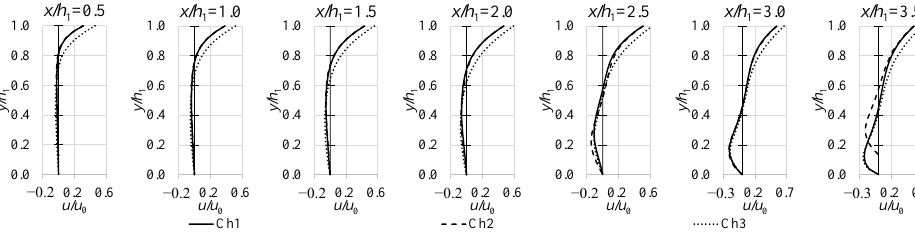
Figure 10. Pressure drop in Ch1, Ch2 and Ch3. 3.2. Investigation of Flow Topology in the x – z Plane Flow streamlines and velocity u profiles measured in the x – y plane are given at y / h 1 = 0.5 (in Figures 11 and 12). At Re = 100, lateral vortices are observed in all investigated cases. Note that longitudinal dimensions differ in every investigated channel due to ge- ometry limitations. For example, the growth of lateral vortices in Ch3 is determined by increased velocity in the centre of the channel; therefore, more kinetic energy is trans- ferred to lateral vortices, thus increasing their size. Further, since the recirculation zone in Ch3 is smaller than in other cases, the difference in reverse flow distribution between Ch3 and Ch1/Ch2 is evident, as can be observed from the x – z plane velocity u profiles (Figure 12). In Ch3, the separated shear layer reattaches to the cavity bottom (Figure 6), and the recirculation zone is smaller than in other cases. Therefore, the effective flow cross-section